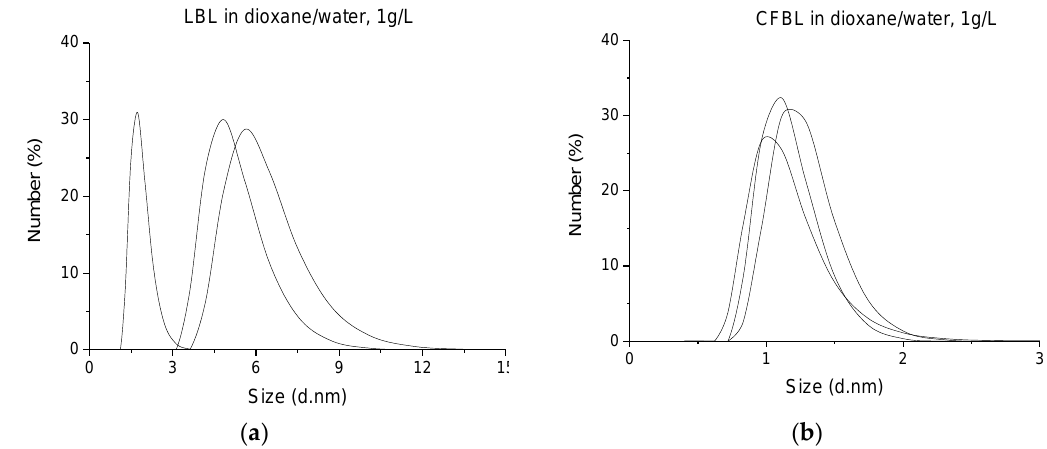
Figure 3. Dynamic light scattering (DLS) diagrams of the particle size distributions of: ( a ) LBL and ( b ) CFBL in a mixture of dioxane/water (4:1).